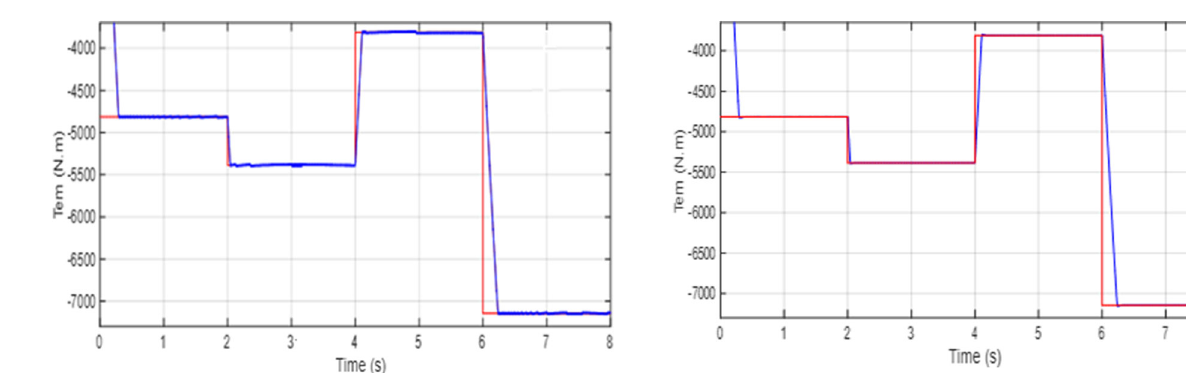
Fig. 14 Electromagnetic torque tracking performance for SMC